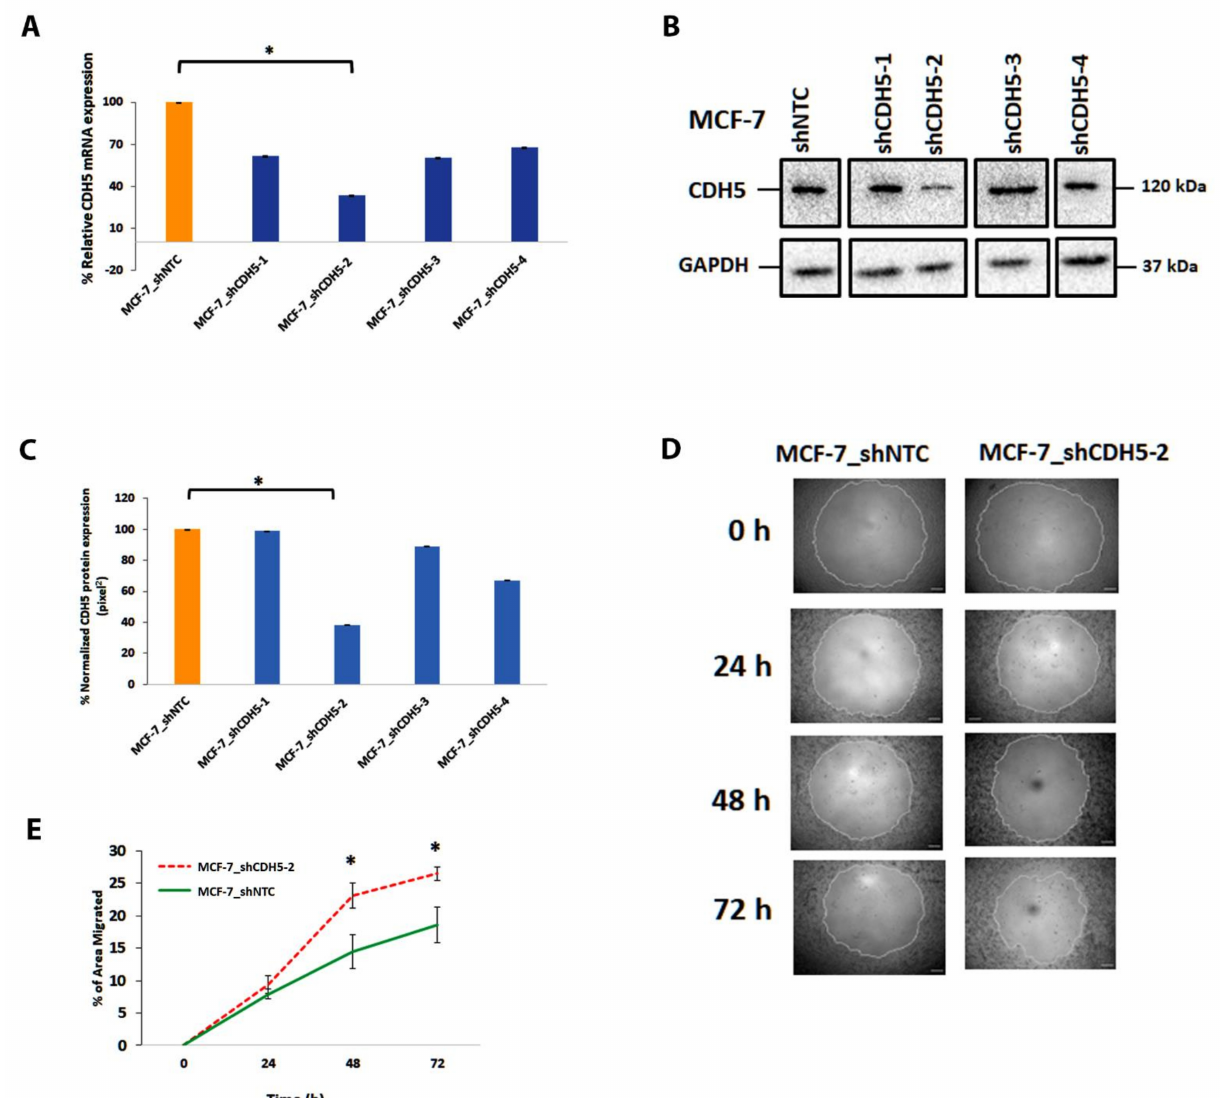
Figure 6. CDH5 knockdown increases MCF-7 migration: ( A ) MCF-7 cells were transduced with recombinant retroviruses expressing 4 different shRNAs (sh1-sh4) for CDH5 or NTC and relative CDH5 mRNA expression was determined by qPCR. Maximum and significant downregulation ( p < 0.01)